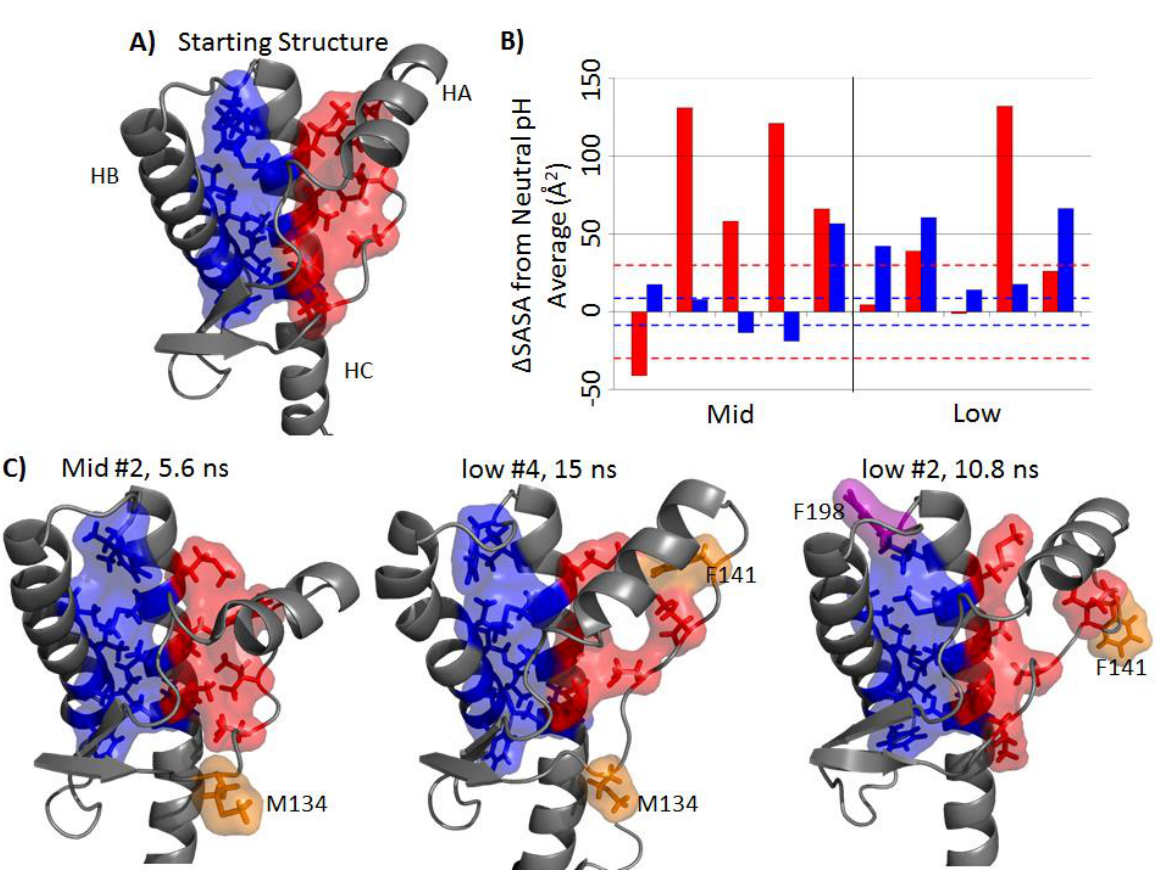
Figure 5. Disruption of the hydrophobic core. (A) Two regions of the hydrophobic core: HA-HC (red) includes residues 134, 137, 139, 141, 205, 209 and 213; HB-HC (blue) includes residues 175, 176, 179, 180, 184, 198, 203, 206, 210, 214 and 215. (B) Side chain solvent accessible surface area (SASA) deviation from the averaged neutral pH simulation for the last 25 ns, where red and blue bars corresponds to the HA-HC and HB-HC hydrophobic core region, respectively. The area within a pair of dotted lines indicates values within one standard deviation of the averaged SASA of the neutral pH simulations. (C) Typical structures where significant SASA increased for mid- and low pH simulations. Magenta and orange residues are residues that become significantly exposed in the HB-HC region and the HA-HC region,